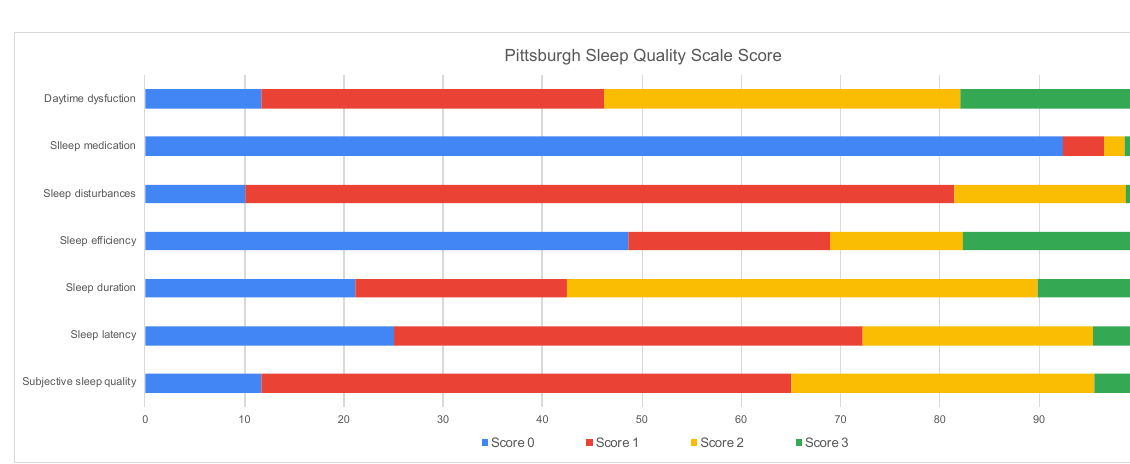
Figure 1. Distribution of the score of each dimension of the PSQI ( n = 3139).